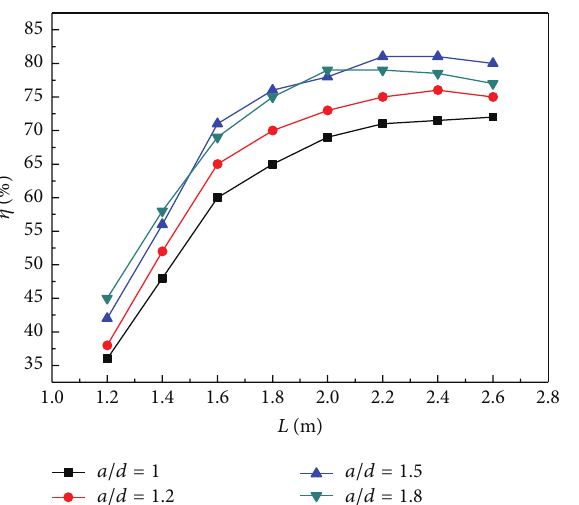
Figure 7: Effect of vibration amplitude on the sieving